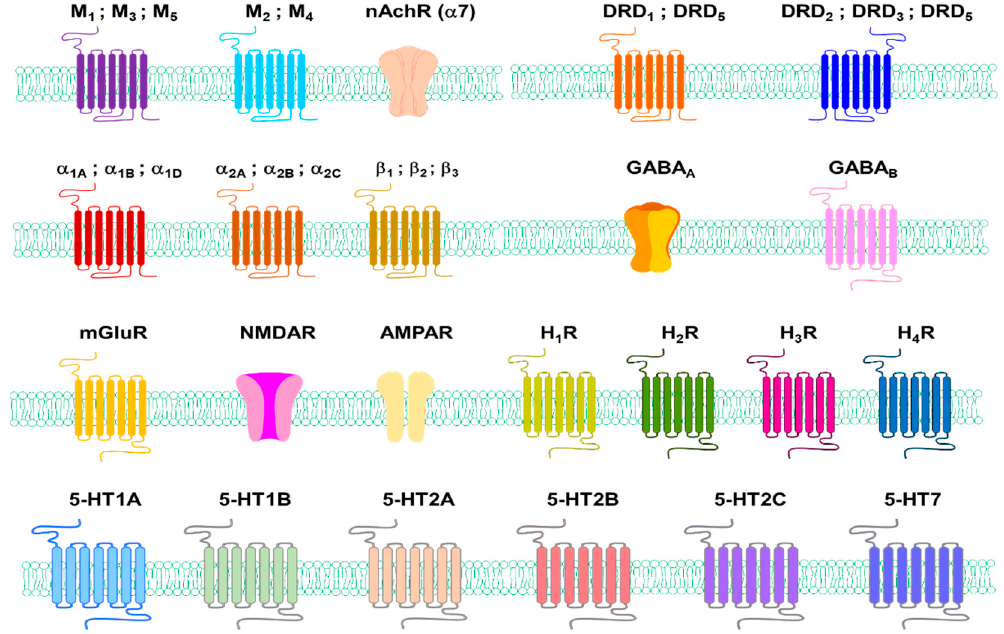
Figure 3. Receptors of amine neurotransmitters.